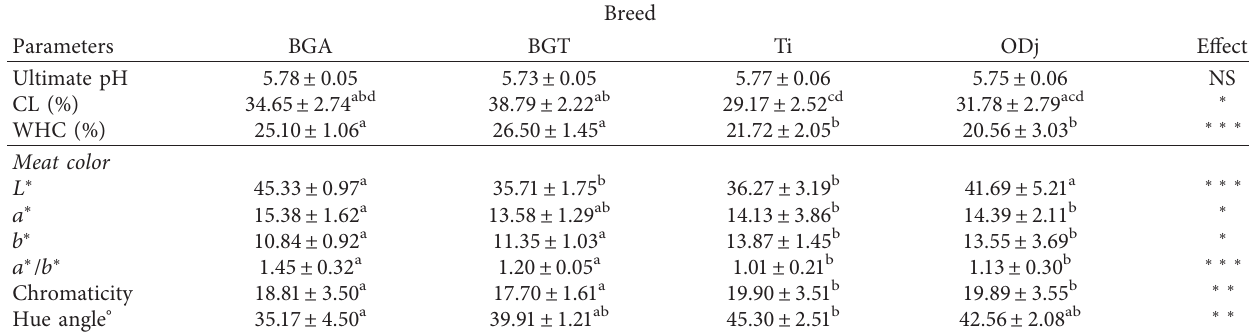
Table 1: Meat characteristics of Beni-Guil, Timahdite, and Ouled-Djellal sheep meats.